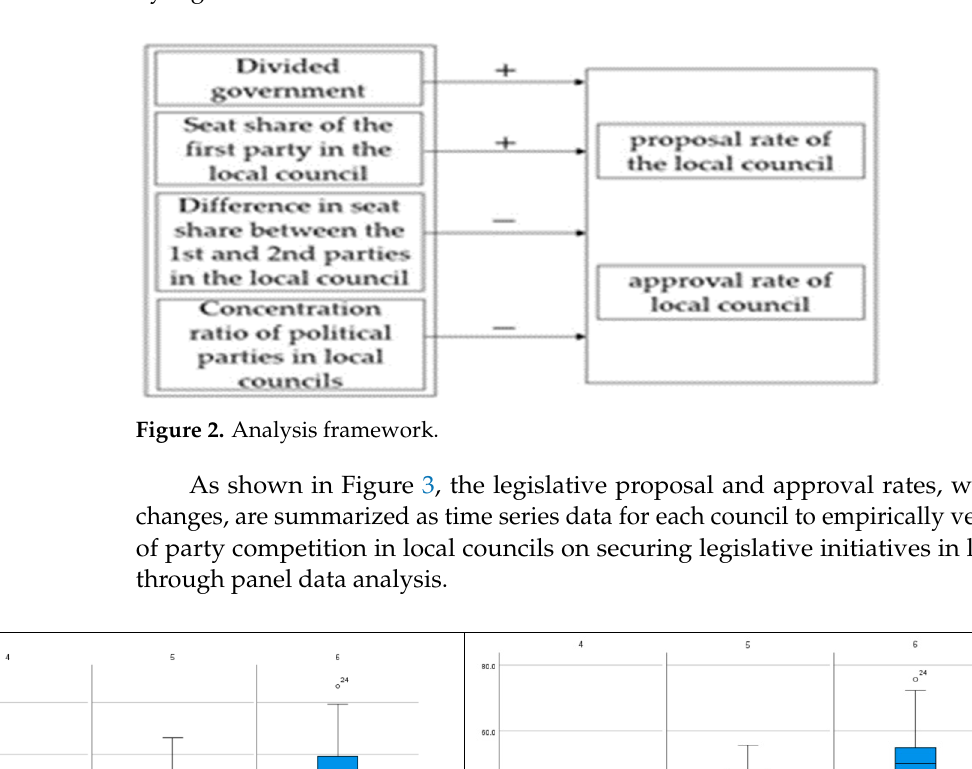
Figure 3. Proposal rate and approval rate transition of 15 local councils from the 4th to 6th terms.